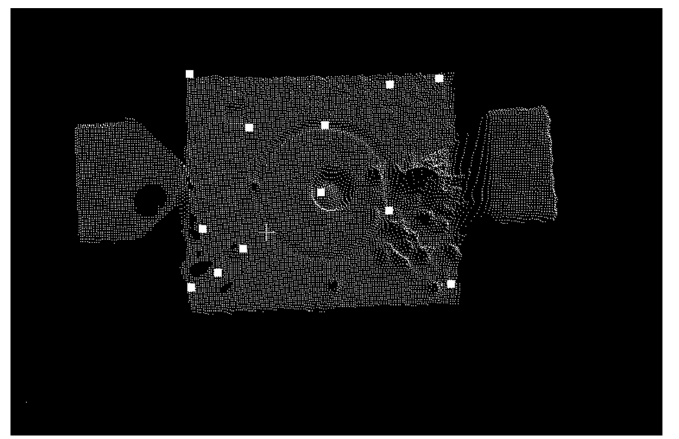
Figure 8. Schematic Pdiagram of the point cloud with the SURF-3D key points.